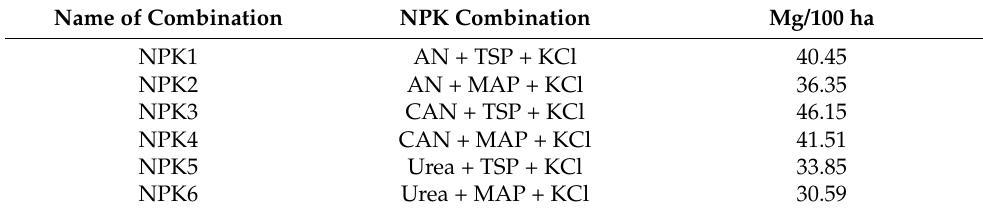
Table 6. Different treatments of the N, P, and K